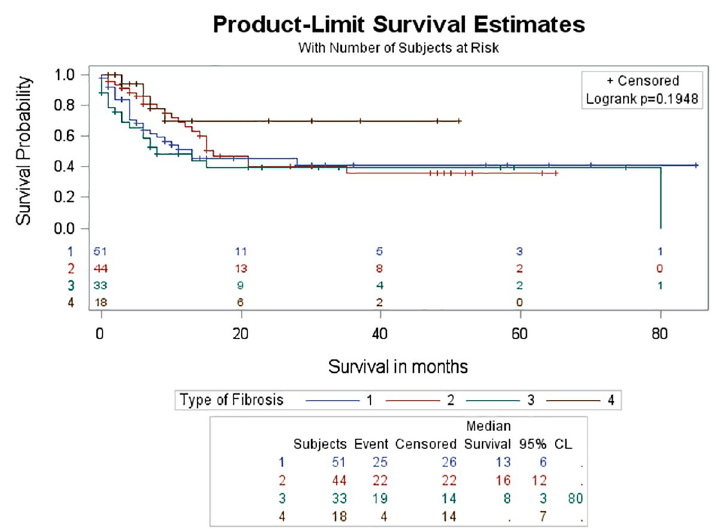
Fig 5. Survival curves between different types of ILD. There was no significant difference in survival rate between different types of ILD (log rank test, p = 0.195).